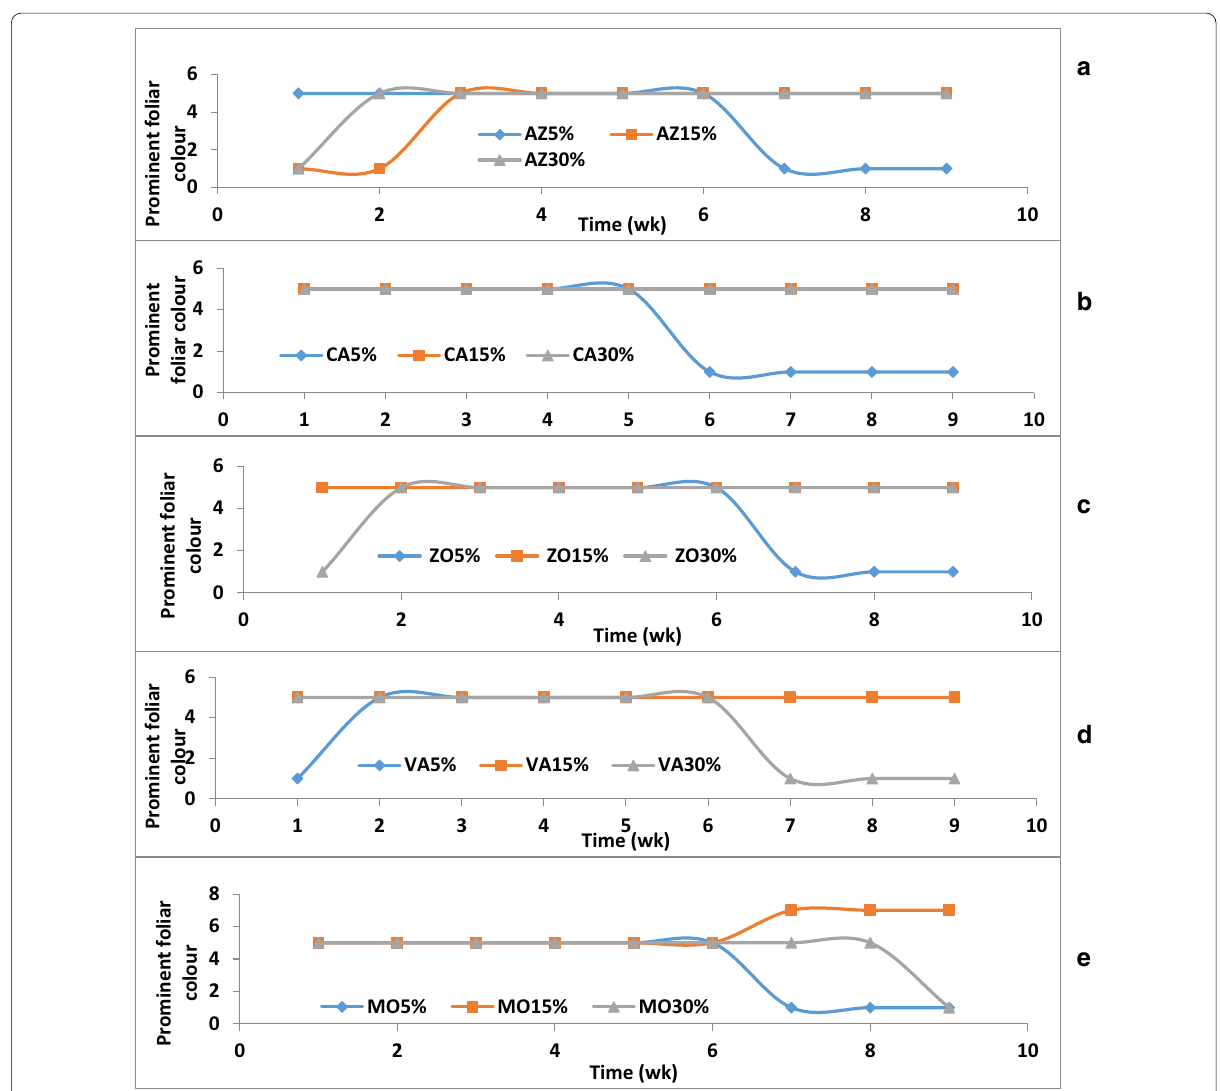
Fig. 4 Changes in foliar colouration during the study. Keys: The foliar colourationpresented are the most prominent leaf colour throughout